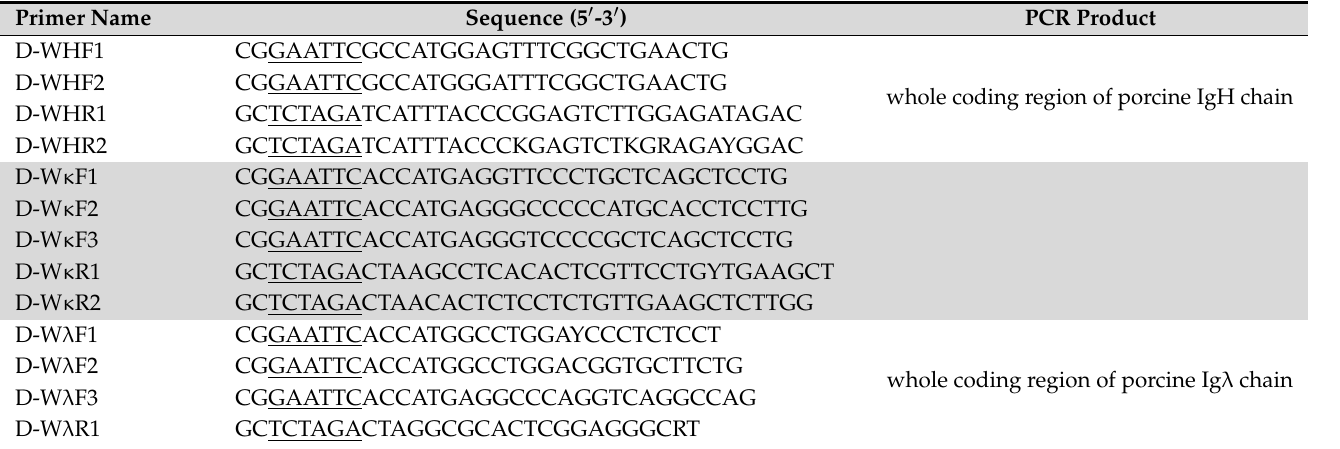
Table 1. Primer sets to amplify the whole coding regions of porcine IgG